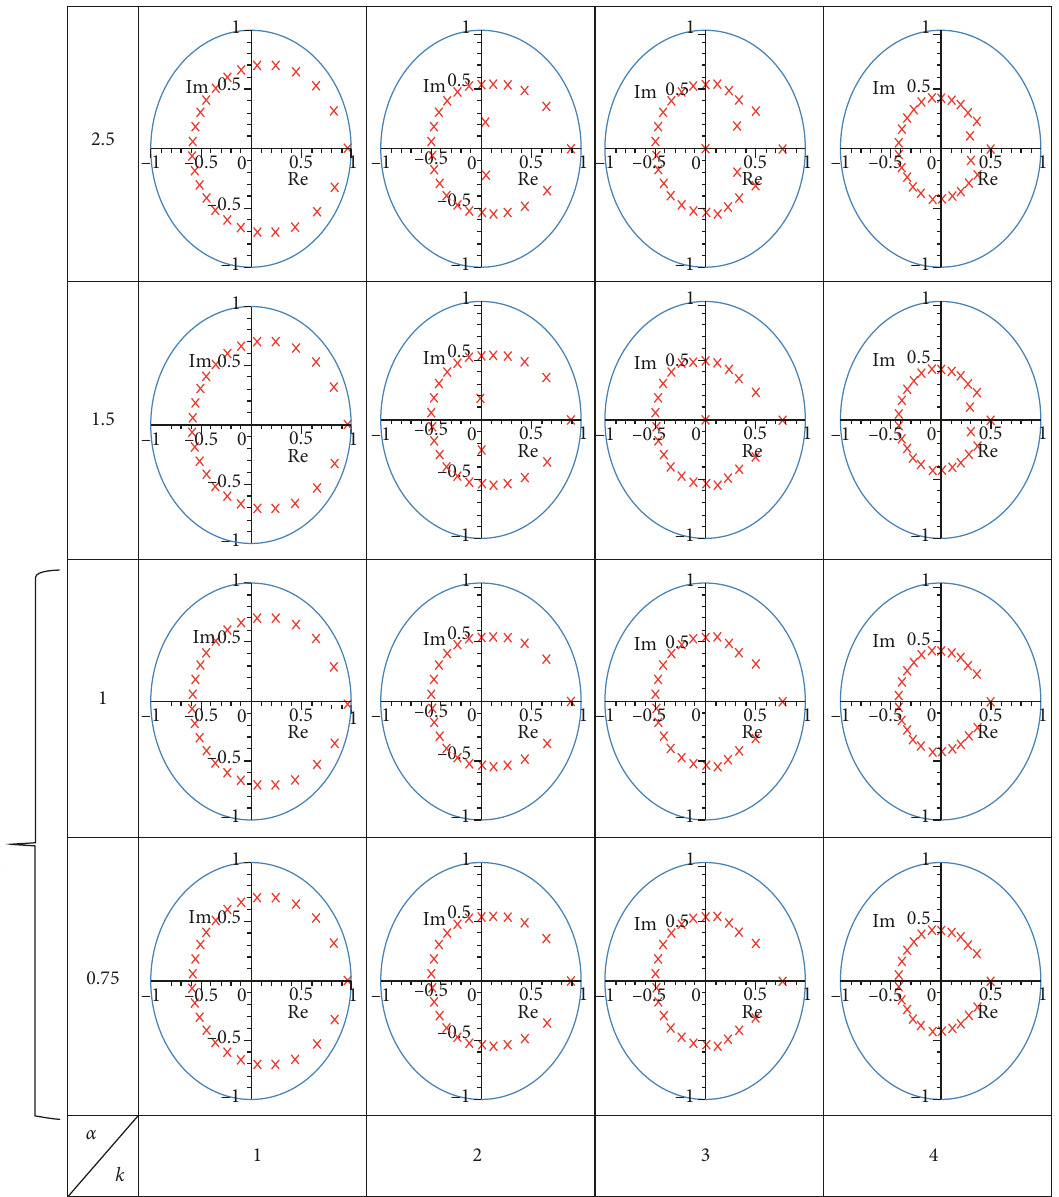
Figure 7: Plotting the roots of the characteristic equation for the Pareto X [ α, k ]/ M /7 queue with b with r � 1 , 000 . We have used μ � 10 − 6 and LC � 10 − 10 , 000